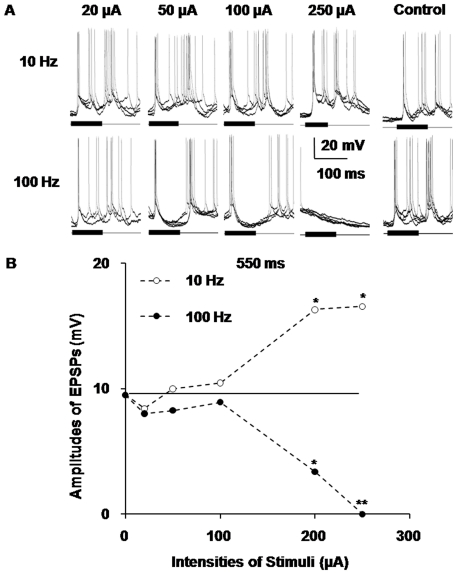
Different responses of AI neurons at varied intensities of train electrical stimulation in the MGBv.
A) The contribution of stimulus intensity to the amplitudes of sound-evoked EPSPs in AI neurons. Compared with the control group, the amplitudes of the sound-evoked EPSPs were augmented with the increasing of the intensities of the train stimulation when the frequency of the train stimuli was 10 Hz. However, the amplitudes of the EPSPs diminished with the increasing of the intensities of the train stimuli in the 100 Hz group. The 10 Hz train electrical stimulation of the MGBv exerted enhancing effects, and the 100 Hz stimulation exerted weakening effects on the AI neuron's responses to acoustic stimuli. When the intensity was lower than 100 µA, the amplitudes of the EPSPs were either higher or lower than the level of pre-stimuli (control group). B) The statistical broken line chart of the average amplitude of the EPSPs evoked by paired sound stimuli after train stimulation of the MGBv at different intensities. The transverse line in the chart was the average amplitudes of the EPSPs evoked only by noises without stimulation of the MGBv, that is, the average amplitudes of the EPSPs in the control group. These data came from the same neuron as in Figure 4. (*P<0.05, **P<0.01).